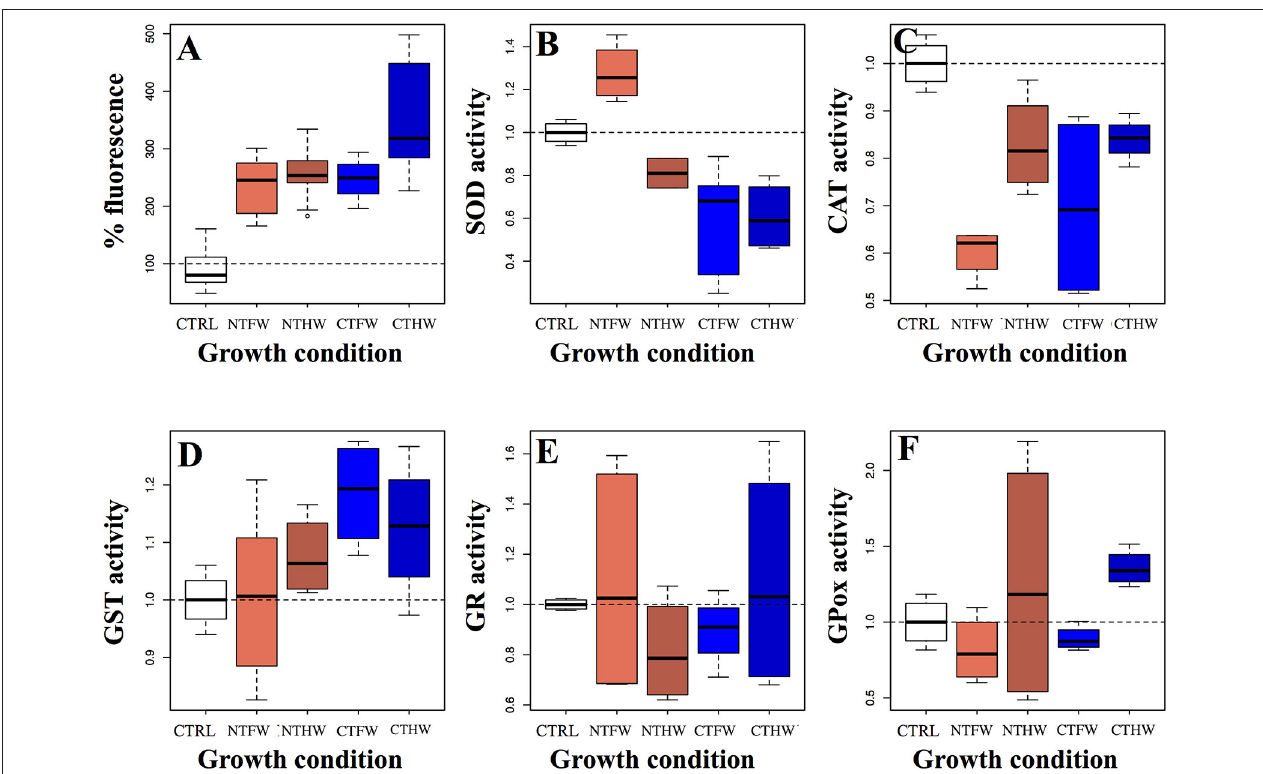
FIGURE 3 | Oxidative stress detection (A) and enzymatic activity assays expressed as fold units compared to a non-treated control (CTRL) of five antioxidant cellular enzymes (B) superoxide dismutase, (C) catalase, (D) glutathione S-transferase, (E) glutathione reductase, (F) glutathione peroxidase performed on Caco-2 cells treated with 100 µ g/mL GAE in the culture medium. CTFW, conventionally tilled and fully watered plots; CTHW, conventionally tilled and half-watered plots; NTHW, not-tilled and half-watered plots; NTFW, not-tilled and fully watered